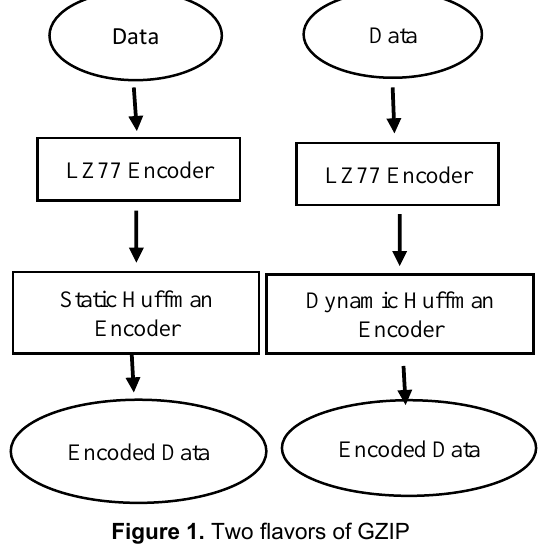
Figure 1. Two flavors of